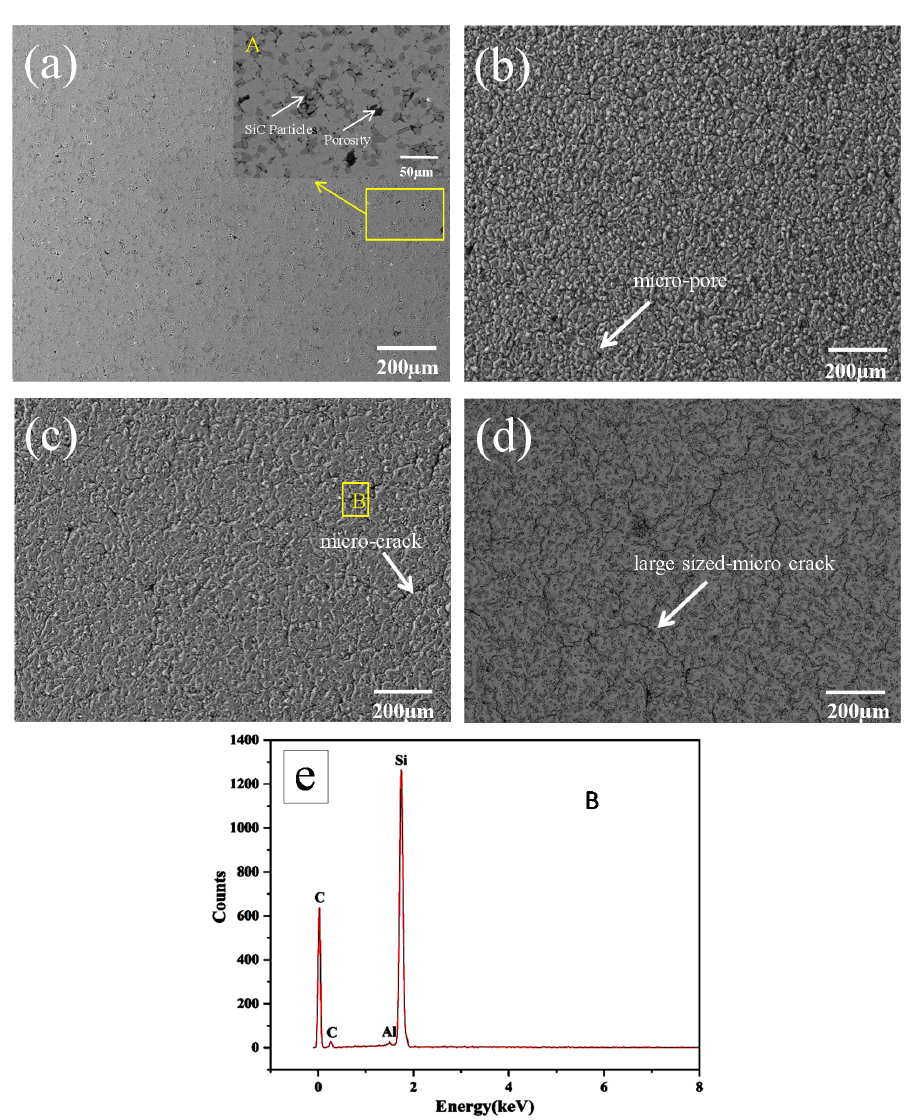
Figure 2. Surface SEM images of Al-20SiC sample before and after HCPEB irradiation: ( a ) initial, ( b ) five pulses, ( c ) 15 pulses, ( d ) 25 pulses (BSE image), and ( e ) EDS results of the A region in Figure 2c.